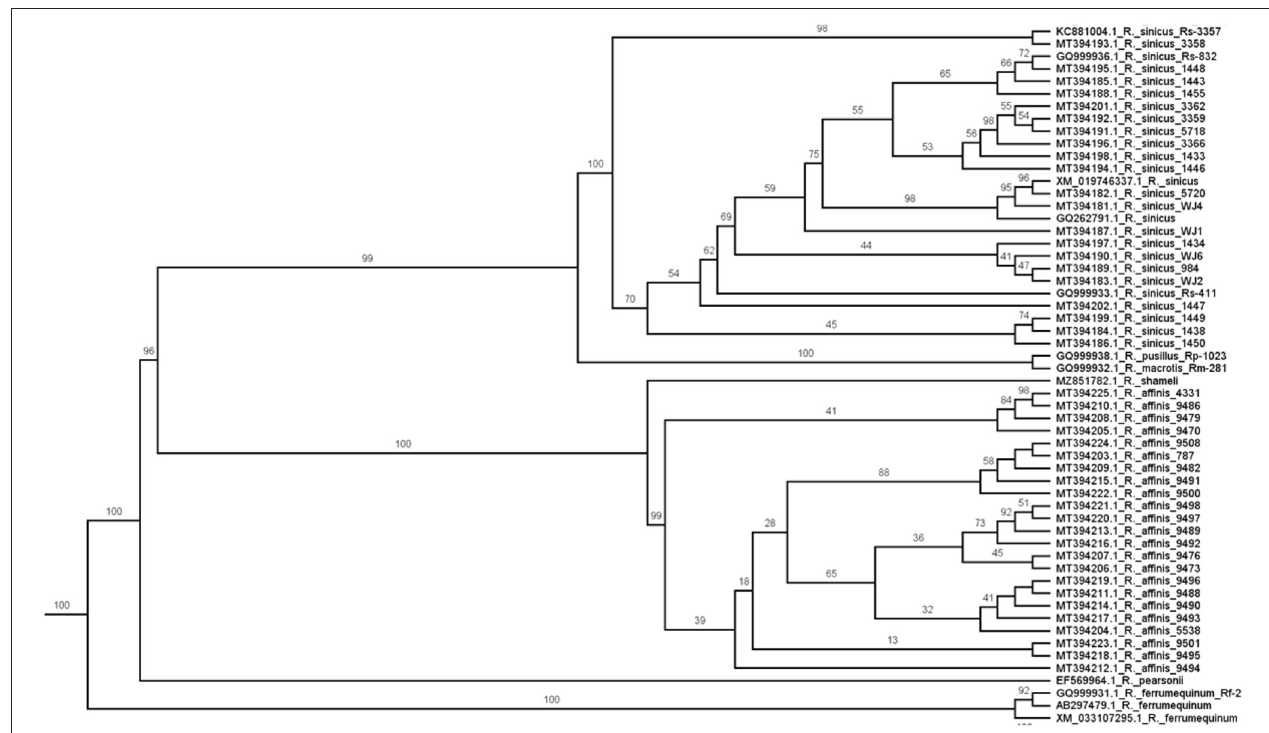
FIGURE 2 | Maximum likelihood phylogeny of the ACE2 gene for bats of the genus Rhinolophus [see also (34)]. Numbers on branches are bootstrap values. Note that all 26 specimens of R. sinicus and all 23 specimens of R. affinis are reciprocally monophyletic. If ACE2 relationships indicate pathways for viral transmission, one would expect the viral phylogeny to be similarly structured but it is not